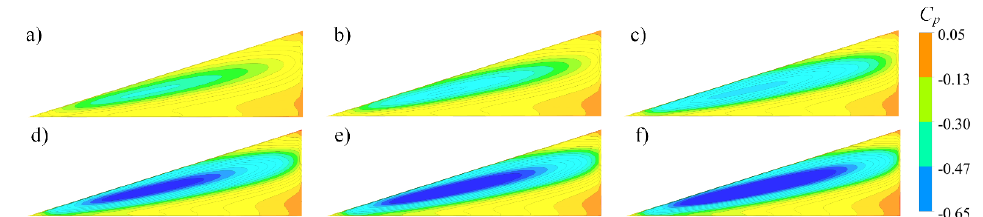
Figure 8. Static pressure iso-contours on the leeward side of the VG. ( a ) H = 0.1 δ , ( b ) H = 0.2 δ , ( c ) H = 0.5 δ , ( d ) H = 1.0 δ , ( e ) H = 1.5 δ , ( f ) H = 2.0 δ .